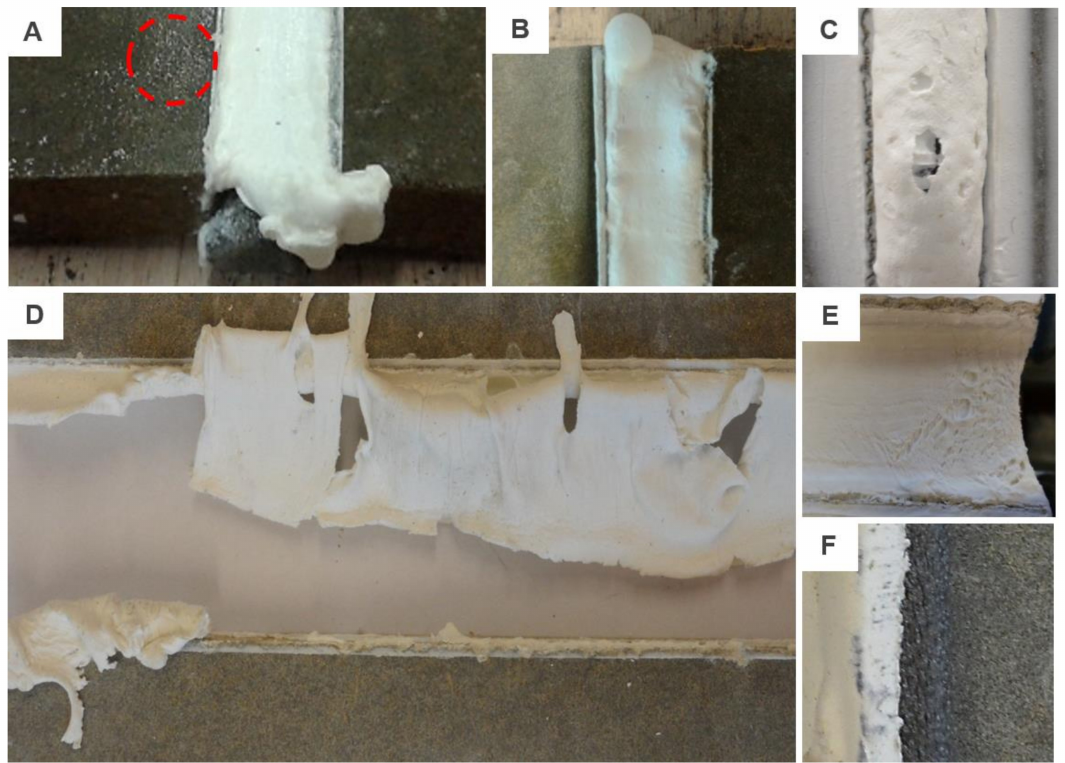
Figure 6. The most common defects of MS / 2 / 2F sealant: ( A ) sample after conditioning to variable temperature changes with small particles (in the red circle) that were drained away from the sealant; ( B ) and ( C ) activation of a foaming process; ( D ) example of the typical failure of samples from the reference batch after elongation to approx. 40%; ( E ) defective surface monitored after a 14-day curing period; ( F ) backer rod glued to the